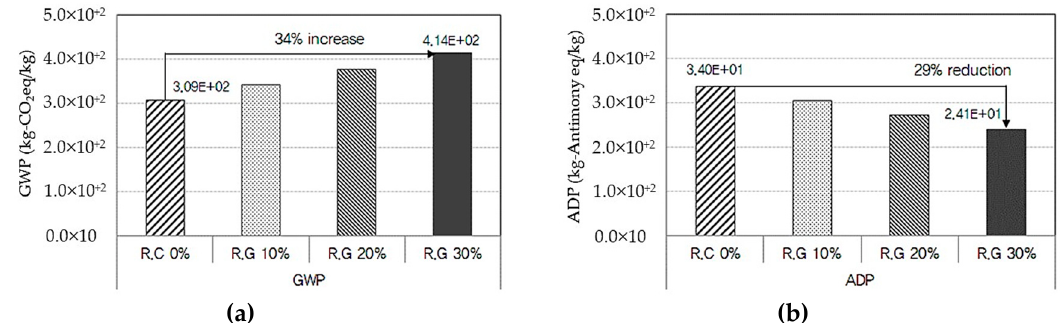
Figure 4. Comparison of environmental impact by recycled aggregate mixing ratio. ( a ) GWP: Global Warming Potential; ( b ) ADP: Abiotic Depletion Potential